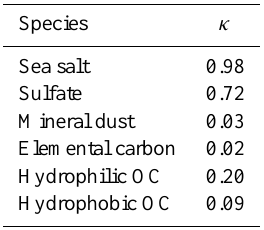
Table 1. Hygroscopicity parameters, κ , used in